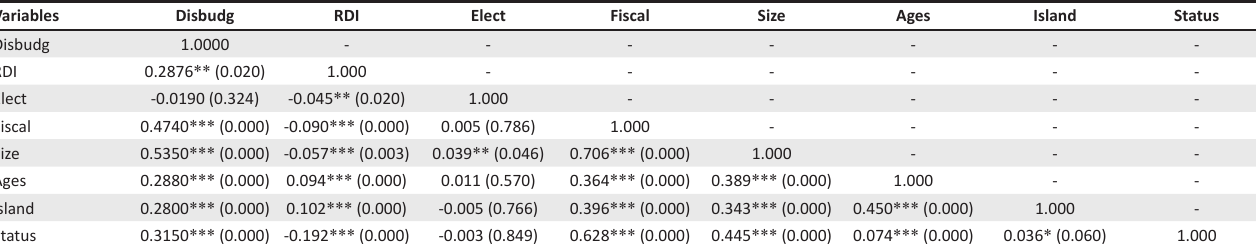
Number of observations = 2609. Explanation of operationalisation of variables in Table